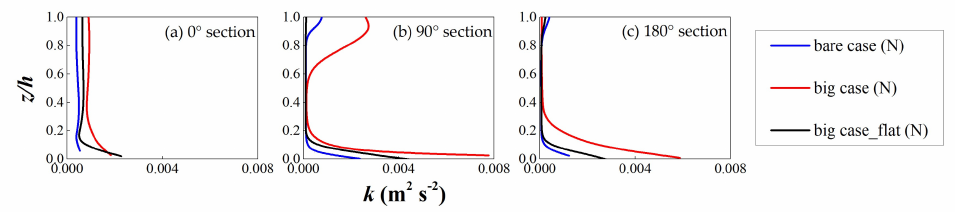
Figure 10. The profiles of TKE ( k ) at the 0 ◦ , 90 ◦ and 180 ◦ sections.